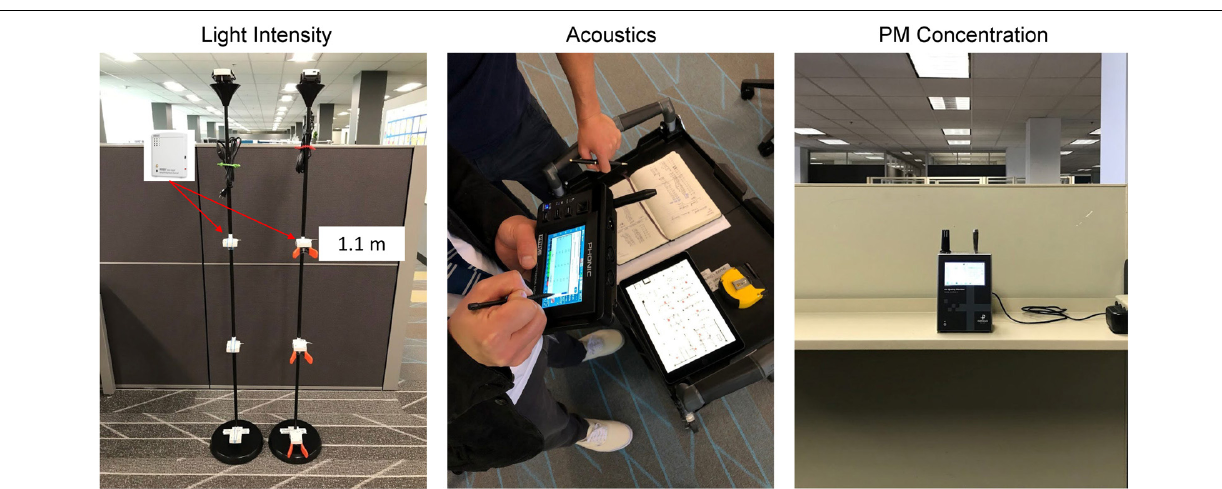
FIGURE 3 | Equipment used for the measurements of environmental